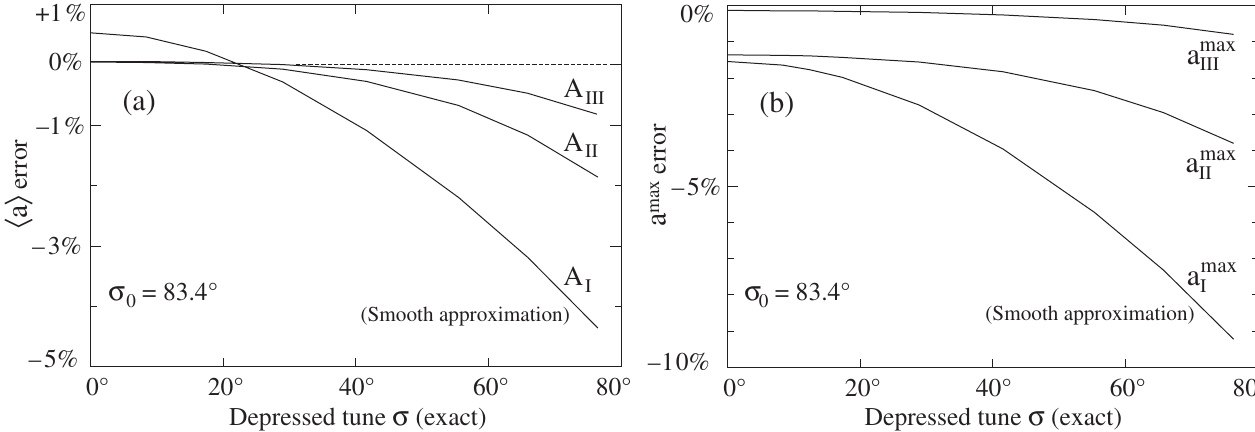
(cid:1)/ K (cid:2) . Q